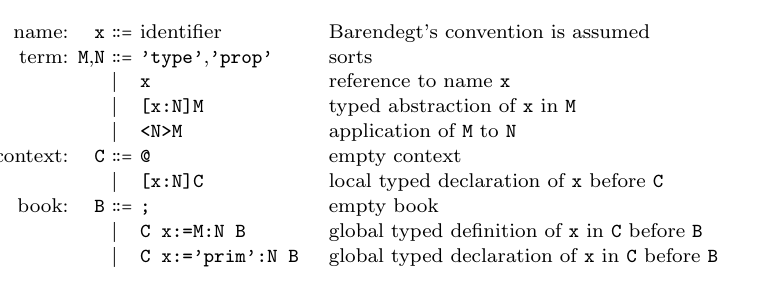
Fig. 1. The abstract syntax of an Automath